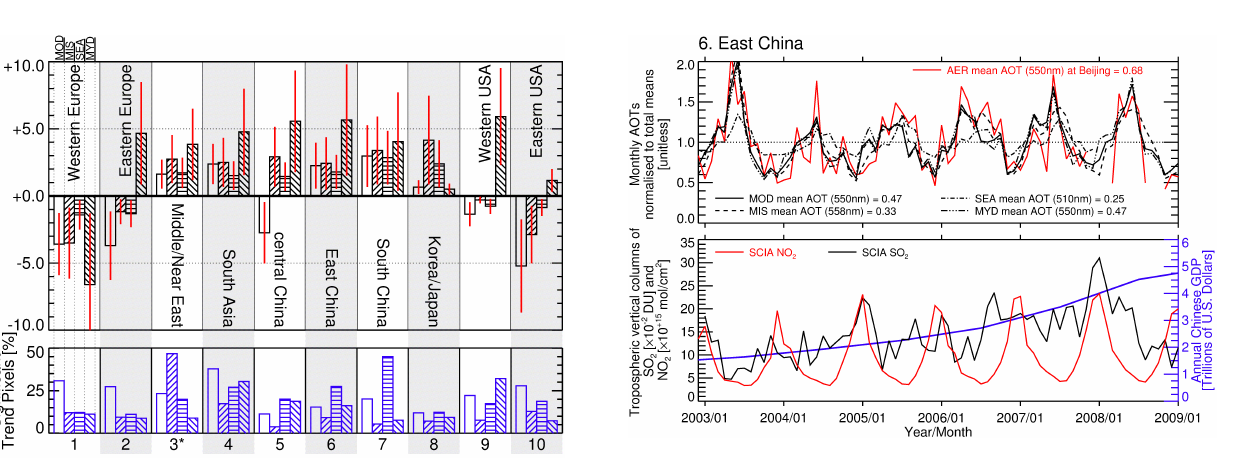
Figure 13. Time series of atmospheric AOTs normalized to their average mean values from the MODIS-Terra (MOD), MISR-Terra (MIS), SeaWiFS-OrbView-2 (SEA), MODIS-Aqua (MYD), and AERONET (AER) data sets; tropospheric nitrogen dioxide and sulfur dioxide columns from SCIAMACHY (SCIA) over eastern China (region 6); and Chinese GDP from 2003 to 2008.